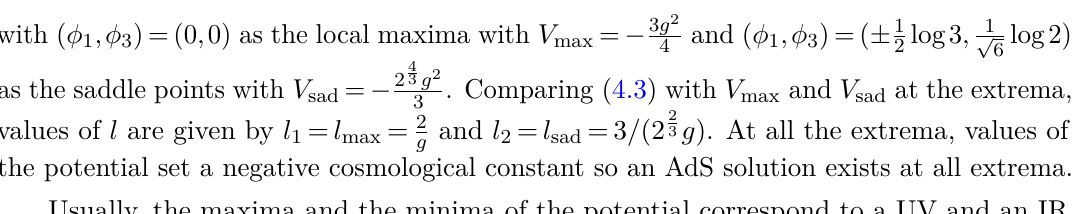
with ( φ ,φ ) = (0 , 0) as the local maxima with V 1 3 as the saddle points with V